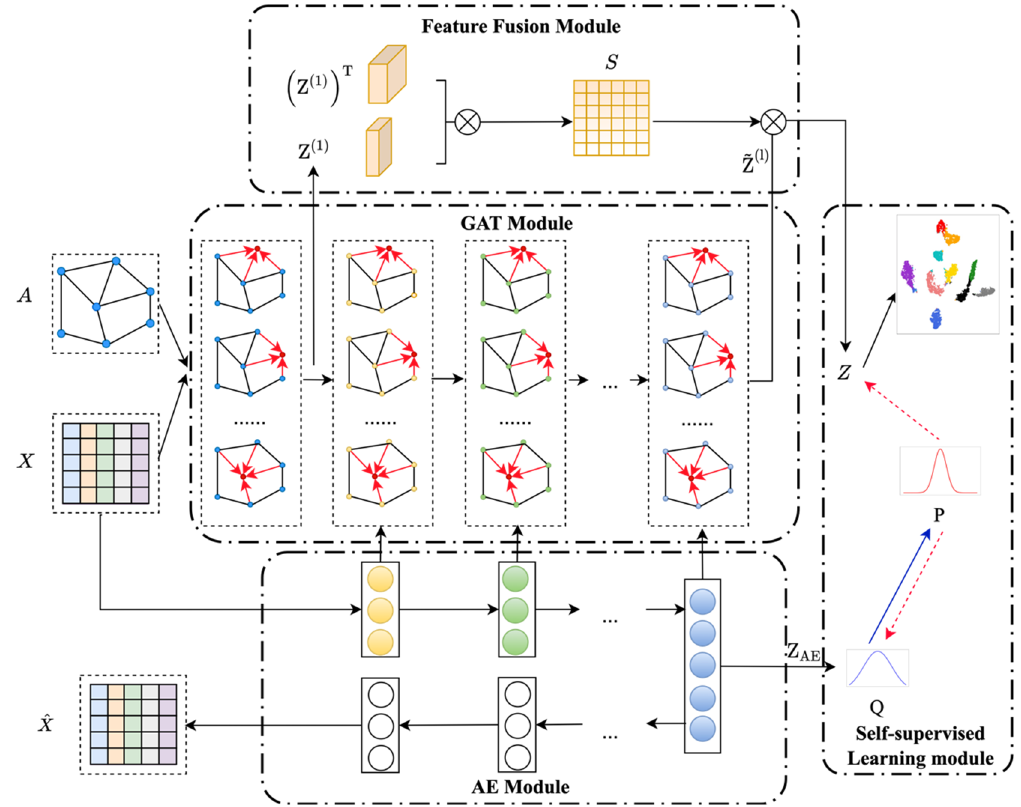
Figure 1. The architecture of the CDFG. A denotes the adjacency matrix of the graph. X is the feature matrix of the node. A and X are both used as input to the GAT module. X is used as input to the AE module. Z AE is the hidden layer representation obtained by the AE module. Z ( 1 ) denotes the first layer representation obtained by the graph attention module. (cid:16) (cid:17) T Z ( 1 ) is the transpose of Z ( 1 ) . S is the self-correlation matrix. (cid:101) Z ( l ) is the representation obtained after the fusion of the GAT module and the AE module. ⊗ denotes the computation of matrix multiplication, and Z is the final representation obtained after fusion. Q is obtained based on the Student’s t -distribution and denotes the distance relationship between Z AE and the clustering centre. P is the target distribution calculated from Q